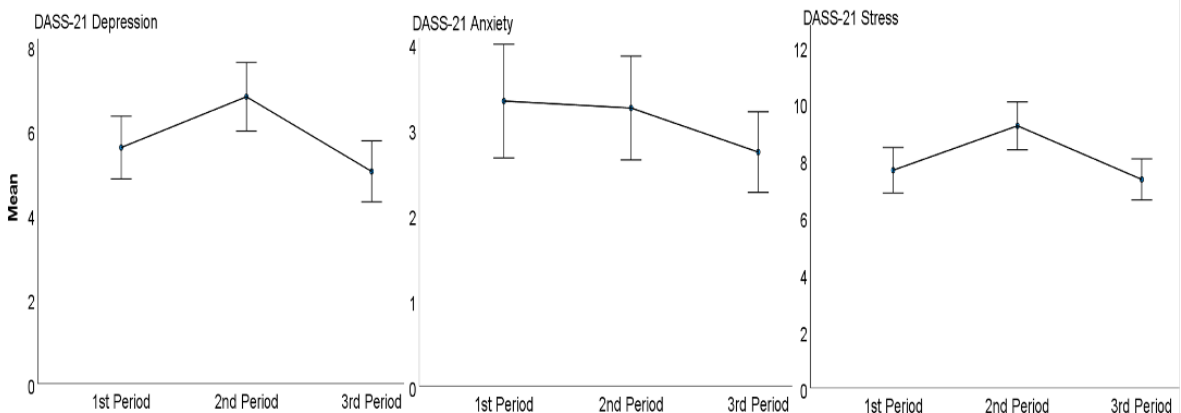
Figure 2. Descriptive plots comparing depression, anxiety, and stress levels, as measured with the DASS-21, between the three periods considered ( n = 268).